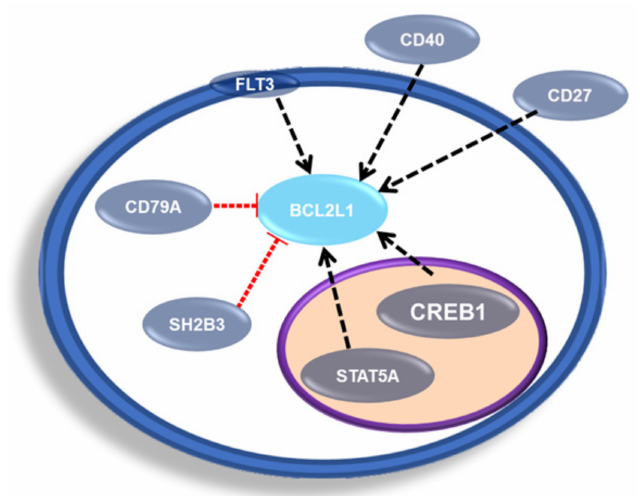
Figure 7. Representative scheme of BCL-xL transcriptional regulators. Schematic representation of transcription factors and proteins involved in the regulation of BCL2L1 transcription.